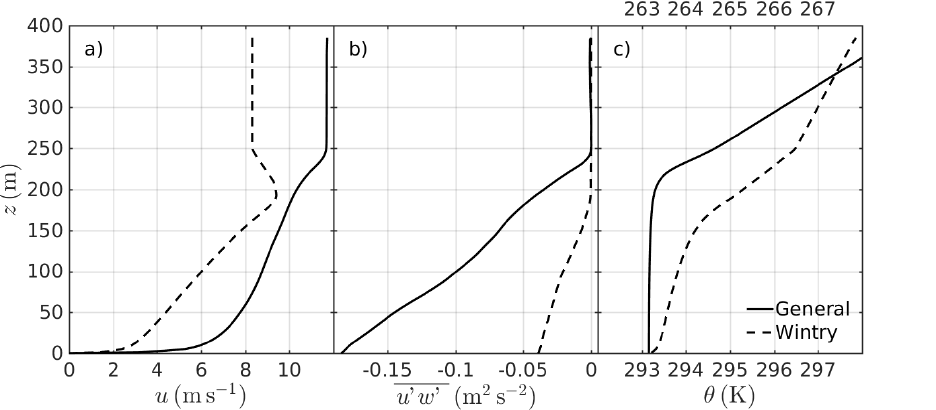
Figure 6. The vertical profile of ( a ) streamwise velocity u (ms − 1 ), ( b ) Reynolds stress u (cid:48) w (cid:48) (m 2 s − 2 ), and ( c ) potential temperature θ (K) at the inflow boundary for the general (solid line) and wintry (dashed line) inflow conditions. The top x -axis for θ is for the wintry